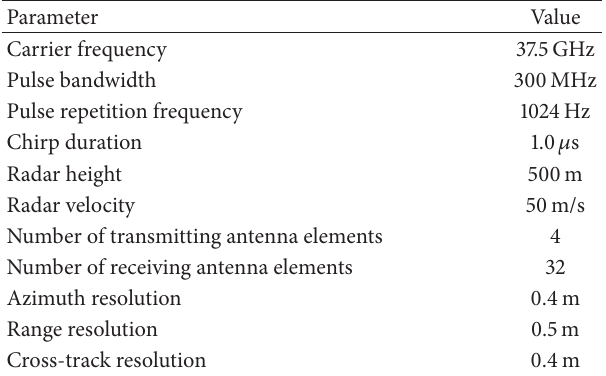
Table 1: Parameters used for